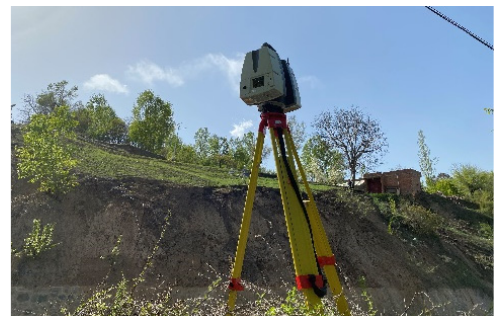
Figure 11. Prism ball target.